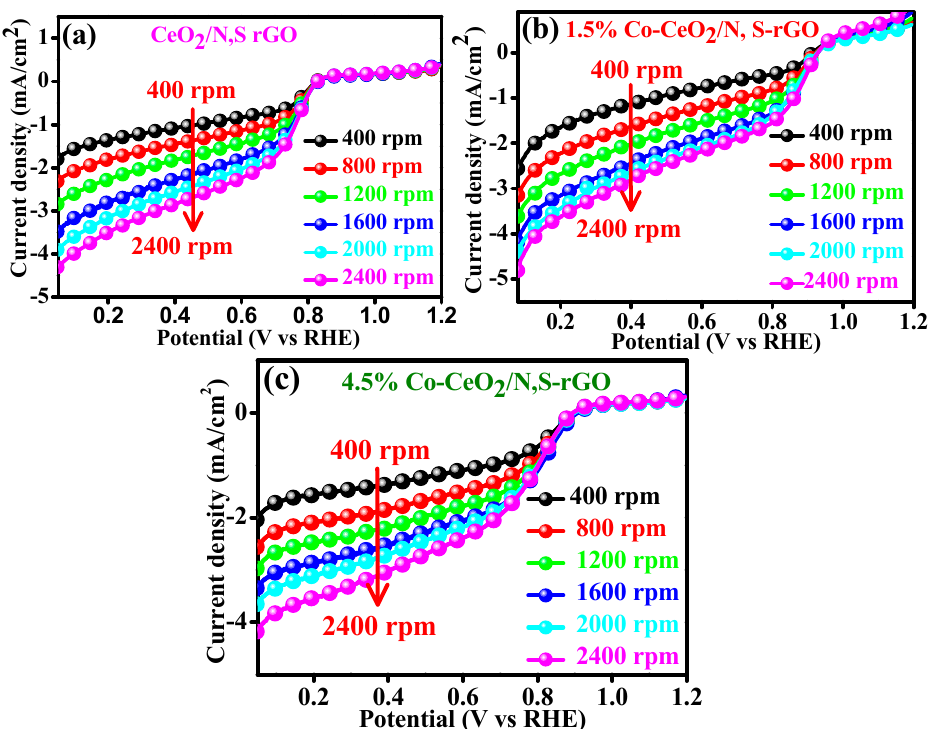
Figure 7. LSV curves of the ( a ) CeO 2 /N, S–rGO, ( b ) 1.5% Co–CeO 2 /N, S–rGO and ( c ) 4.5% Co–CeO 2 /N, S–rGO.